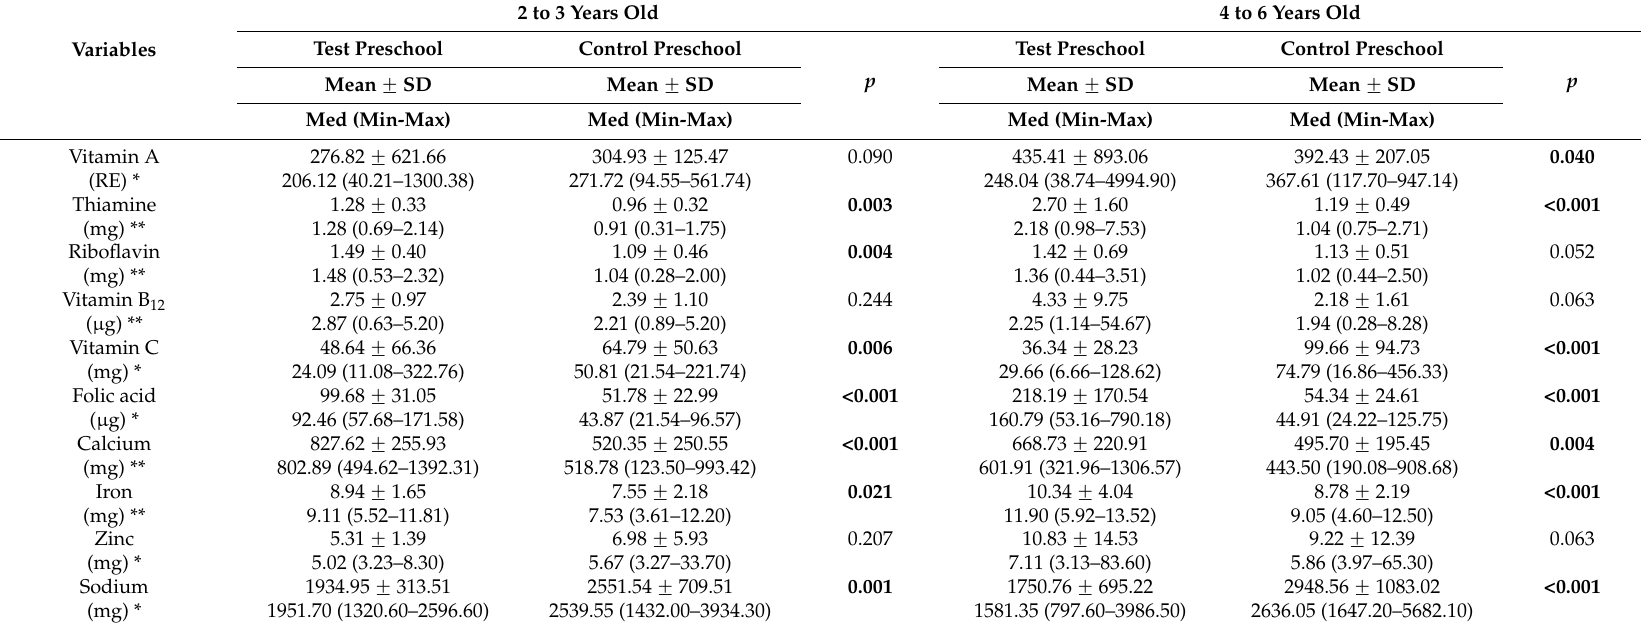
Table 4. Comparison of the ingestion, at home and at the preschool, of micronutrients between preschoolers from two philanthropic preschools.